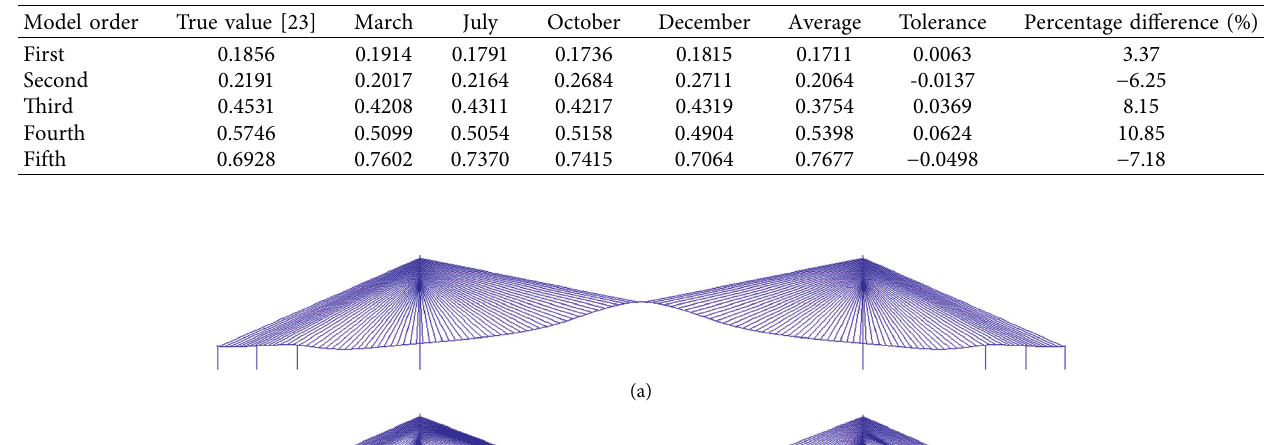
Table 4: Comparison between EEMD results and real values (Hz).